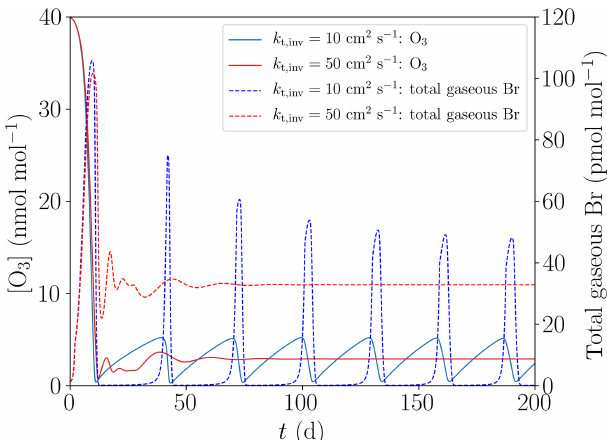
Figure 5. Evolution of O 3 and total gaseous bromine mixing ratios for k t , inv = 10 and 50cm 2 s − 1